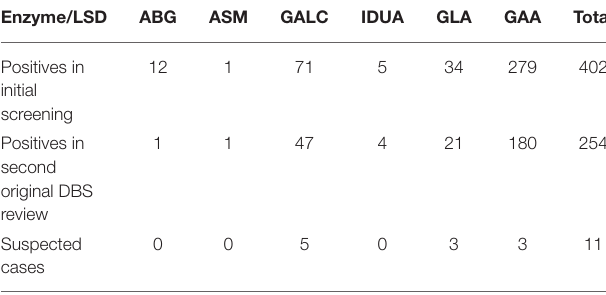
TABLE 1 | The rate of screening positive, review positive, and confirmed disorders in LSD newborn screening (due to lack of reagents, not all the initial screening positives on July 22 and July 27, 2020, were followed up).